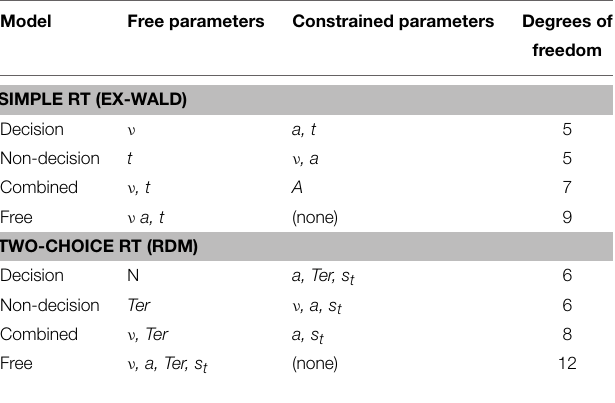
TABLE 1 | Co-activation models with free and constrained parameters, and degrees of freedom.